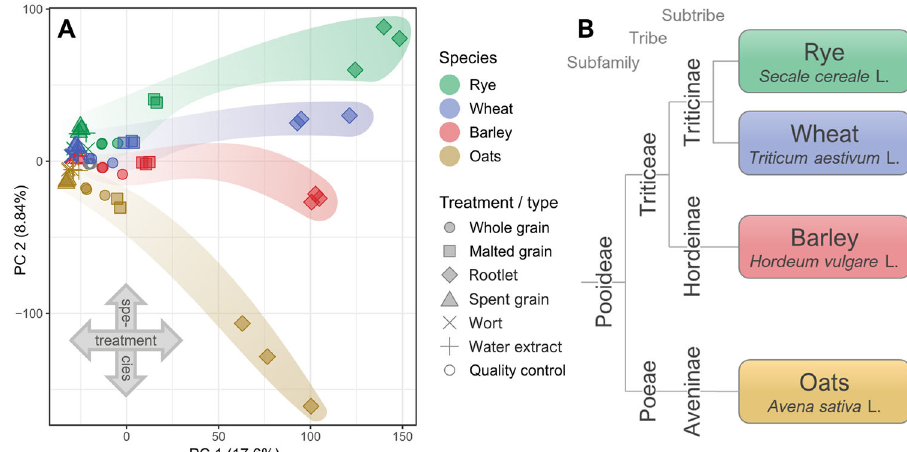
Fig. 2 The impact of malting on metabolite pro fi les of cereals and relation to their phylogeny. a Principal component analysis (PCA) of the most intense molecular features ( n = 12,544, average signal abundance >200,000) in the complete dataset, visualizing the data reduced into the two main orthogonal components explaining the maximal proportion of the variation between samples. Principal component 1 (PC 1) explains 17.6% of the variability between the metabolic pro fi les of the samples and roughly corresponds with the treatment effect. PC 2 explains 8.84% of the between samples variation and indicates differences between the cereal species. b A simpli fi ed phylogenetic classi fi cation of the four studied temperate cereals, according to Soreng et al. 52